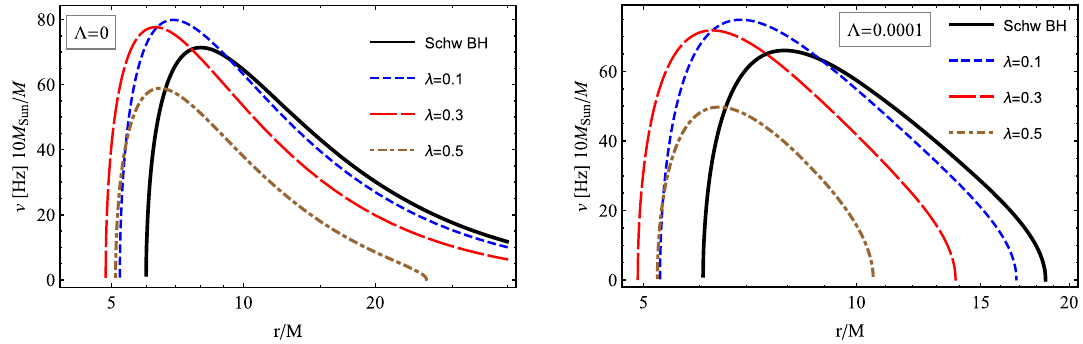
Fig. 10 Radial profiles of frequencies of radial oscillations of test particles around a pure Schwarzschild (left panel) and Swcharzschild–de Sitter (right panel) black hole immersed in a perfect fluid dark matter field for different values of λ . In this plot, we use Λ → Λ/ M 2 and λ → λ/ M